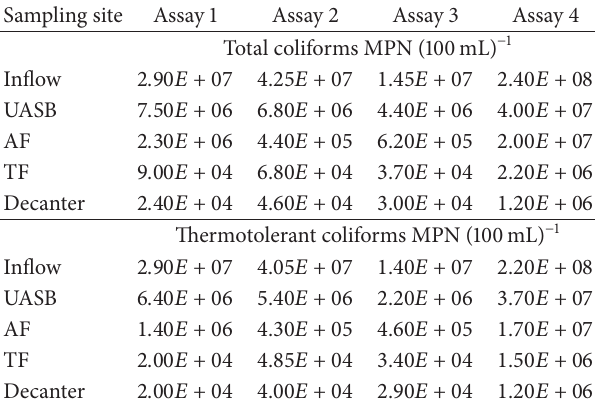
Table 3: Average values of the most probable number of total and thermotolerant coliforms in the inflow and effluents of treatment system II consisting of UASB reactor, anaerobic upflow filter (AF), trickling filter (TF), and decanter (D) placed in series, in assays 1, 2, 3 and